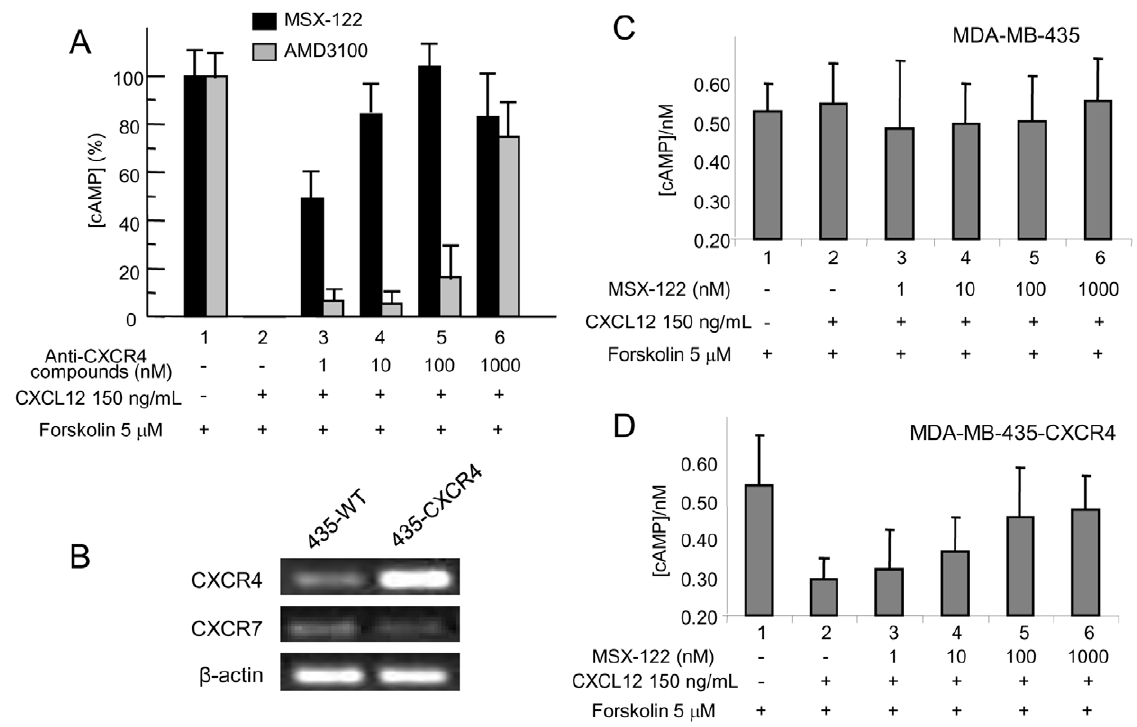
Figure 3. Comparison of inhibition of cAMP modulation by MSX-122 and AMD3100. (A) With 15 min pre-treatment with MSX-122 or AMD3100 at various concentrations, the effect of 150 ng/ml of CXCL12 on cAMP reduction was measured by the TR-FRET based LANCE assay kit using U87CD4CXCR4 cells. (B) RT-PCR analysis of CXCR4 and CXCR7 mRNA in wild-type MDA-MB-435 cells. CXCR4-overexpressing MDA-MB-435 cells were generated by transfection using a CXCR4 expressing plasmid (Missouri S&T cDNA resource center) and Lipofectamine2000. (C) No effect of MSX- 122 on cAMP reduction induced by 150 ng/ml of CXCL12 in CXCR4-negative, wild-type MDA-MB-435 cells. (D) The effect of MSX-122 on cAMP reduction induced by 150 ng/ml of CXCL12 in CXCR4-overexpressing MDA-MB-435